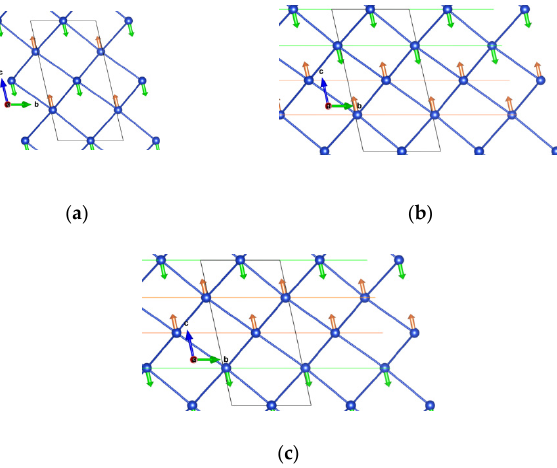
Figure 4. Description of the antiferromagnetism (AFM) orders supported by the triclinic unit cell (dark lines). ( a ) + + − − (G-AFM type) order. ( b ) + − + − , and ( c ) − + + − : double-layered AFM orders, with (001) FM triclinic planes (equivalent to (111) pseudocubic planes).